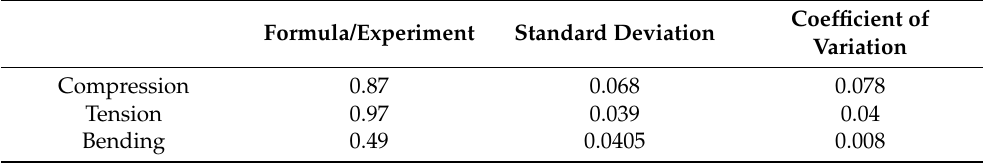
Table 12. Reliability verification of the stiffness